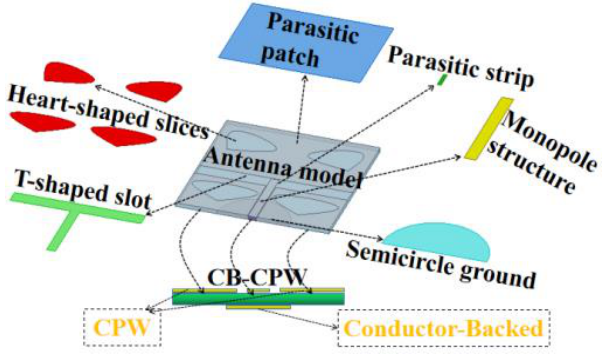
Figure 1. Explosive decomposition structure.